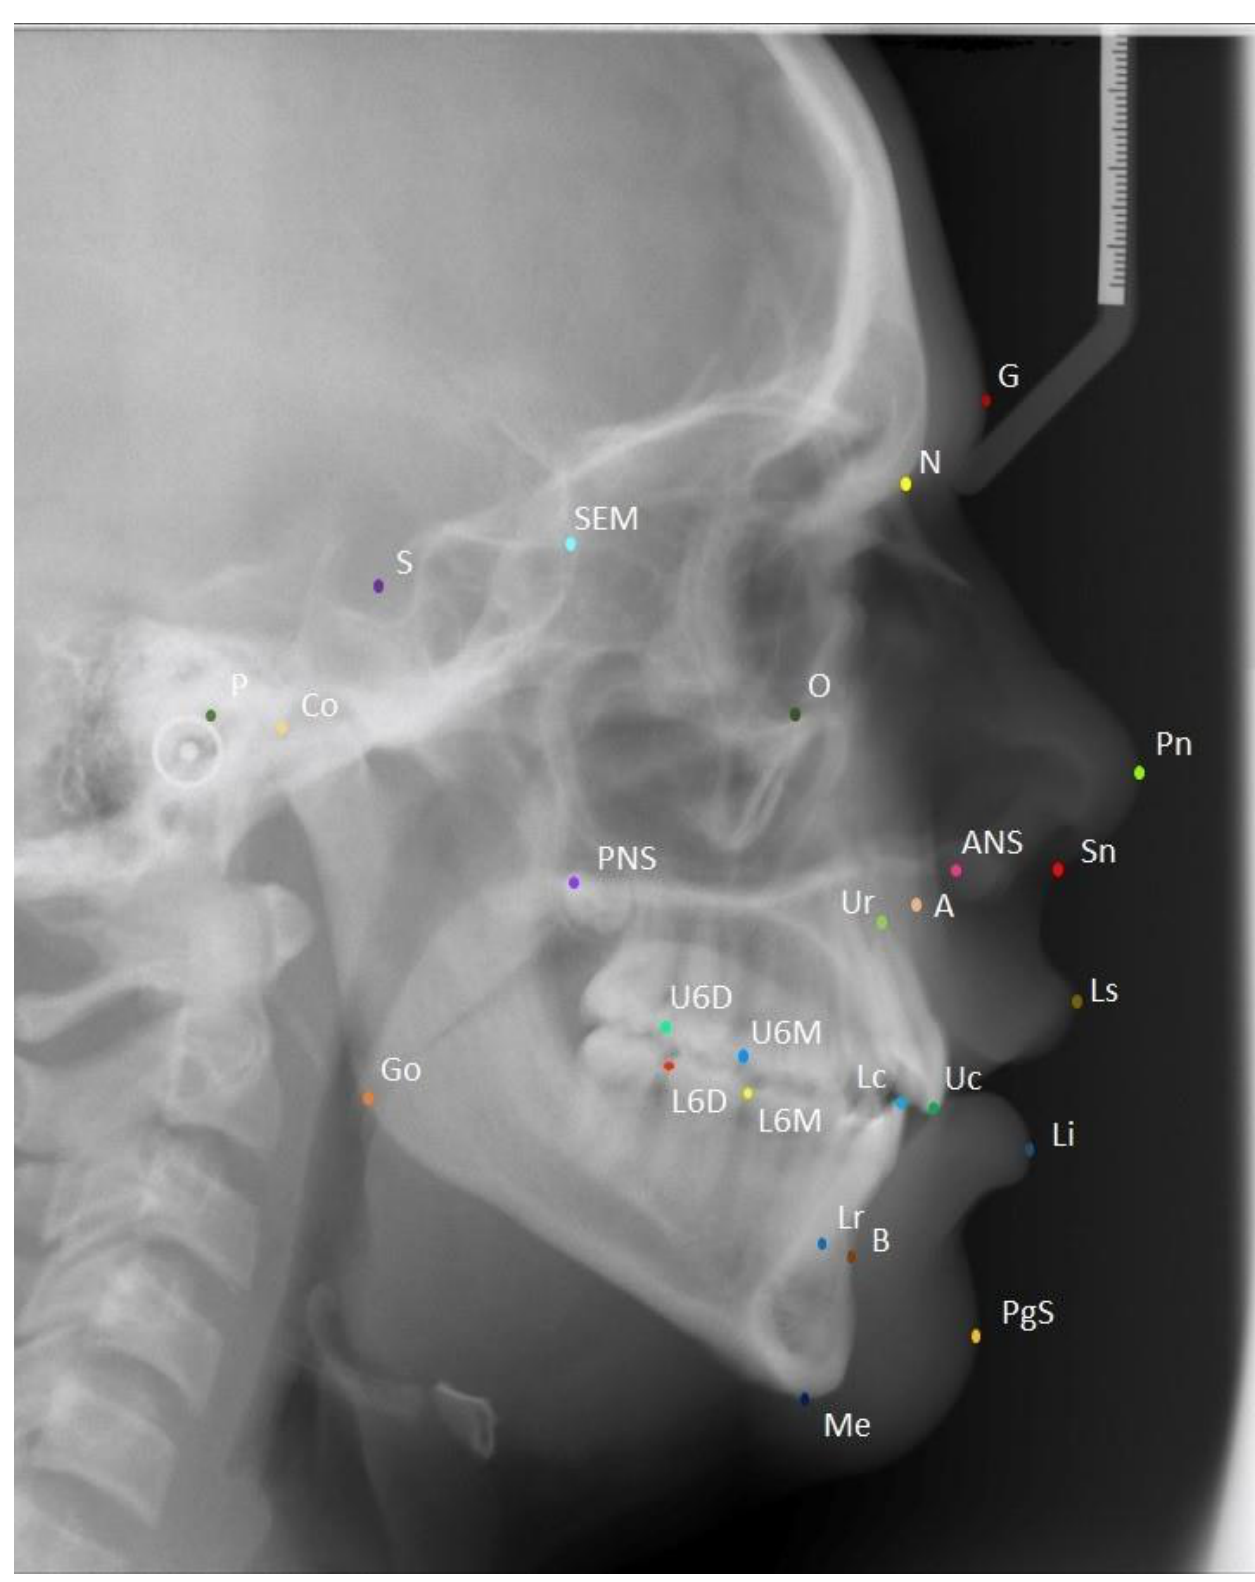
Figure 1. A sample cephalometric X-ray showing the true positions of the 26 cephalometric land- marks.